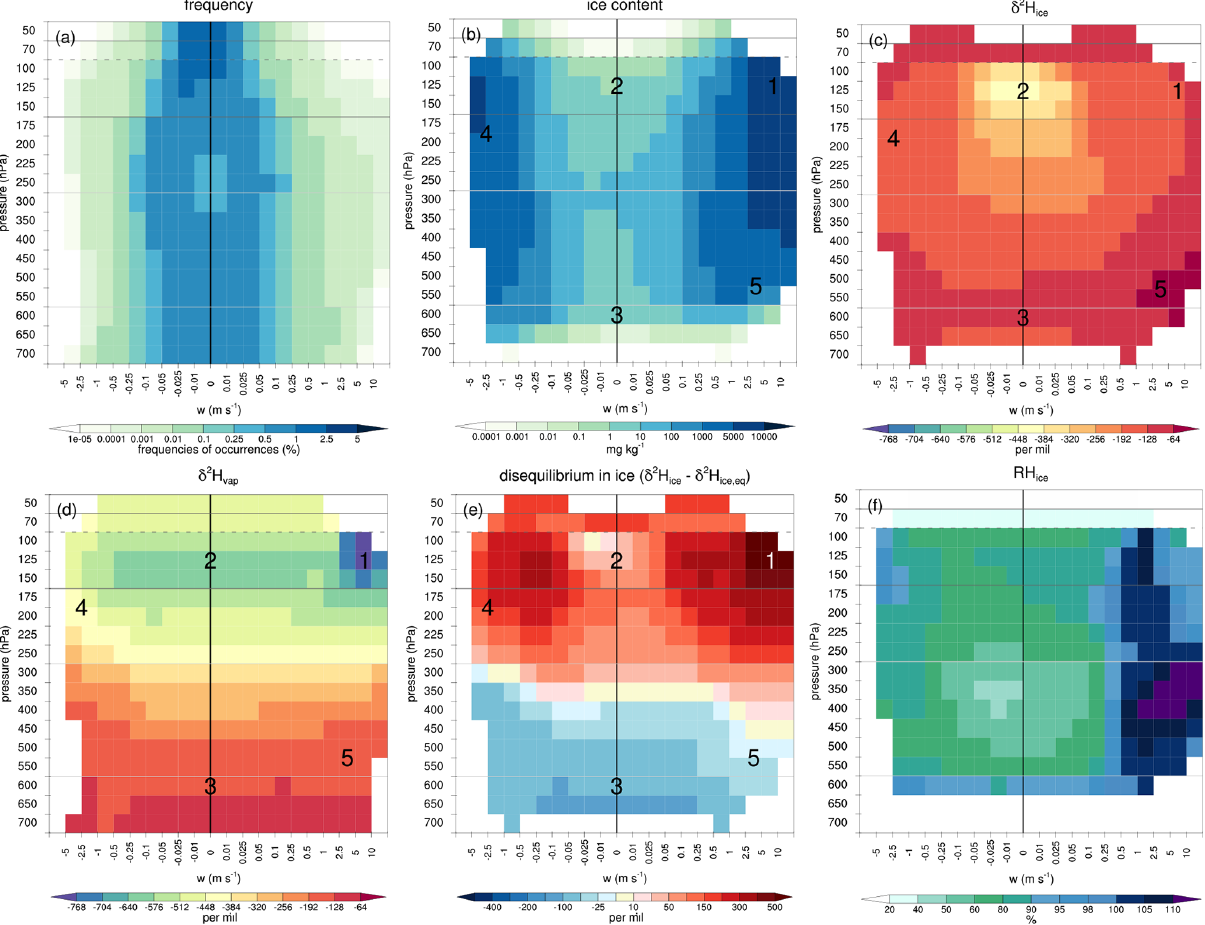
Figure 10. Frequency distribution and isotopic composition of water species as a function of vertical motion across pressure levels in the region of interest for July 2016 for (a) frequency occurrences (%), (b) ice content (mgkg − 1 ), (c) δ 2 H in ice (‰), (d) δ 2 H in vapour (‰), (e) disequilibrium in ice (‰), and (f) relative humidity with respect to ice (%). Values in panels (b) – (f) are transparent when the frequency occurrences are below 10 − 5 %, and they are also transparent in panels (c) and (e) if the average ice content falls below 10 − 4 mgkg − 1 . Note the irregular intervals and asymmetric distribution of the vertical motion bins, as indicated on the x